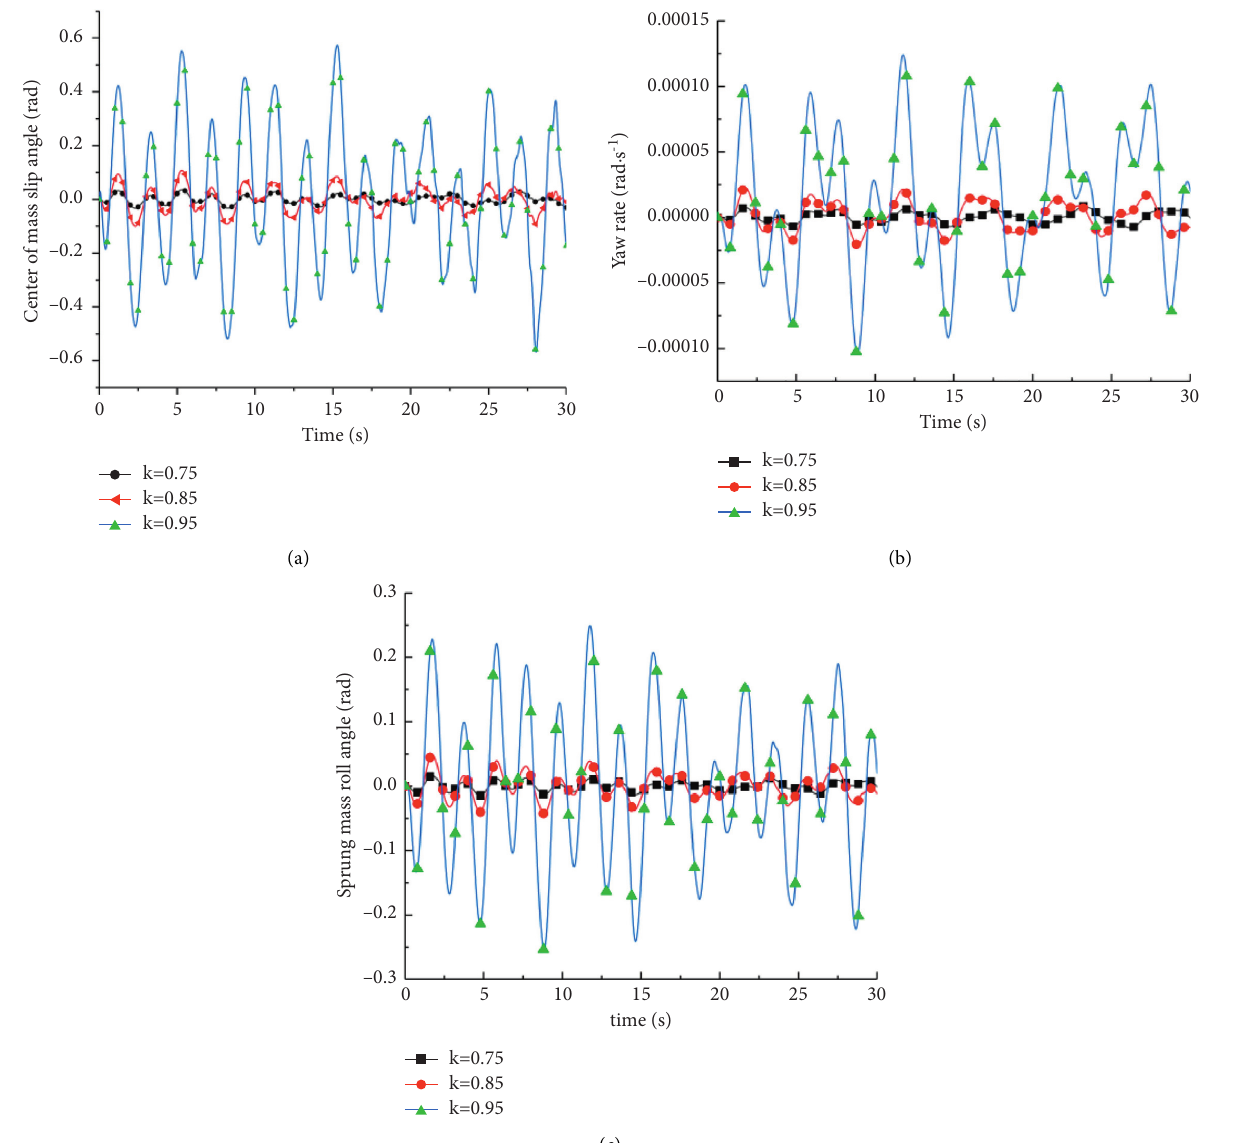
Figure 15: Simulation results of different filling ratio. (a) Variation curve of the slip angle of the center of mass. (b) Variation curve of yaw angular velocity. (c) Variation curve of mass roll